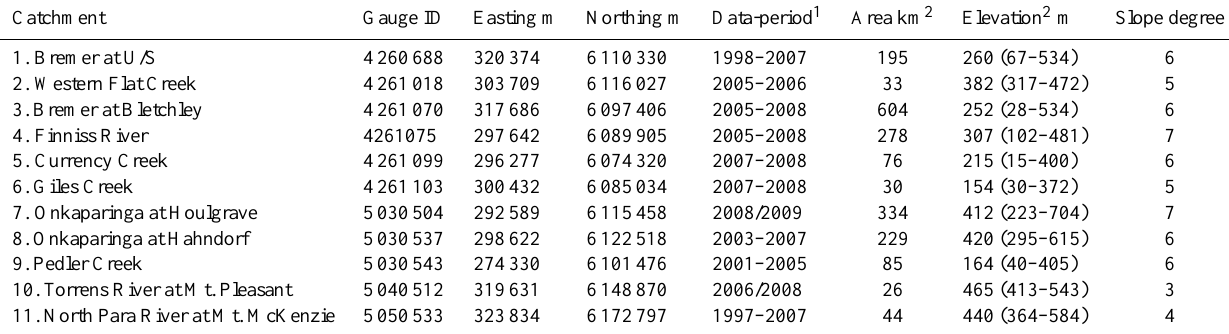
Table 2. Eleven selected catchments in the Mount Lofty Ranges and related site